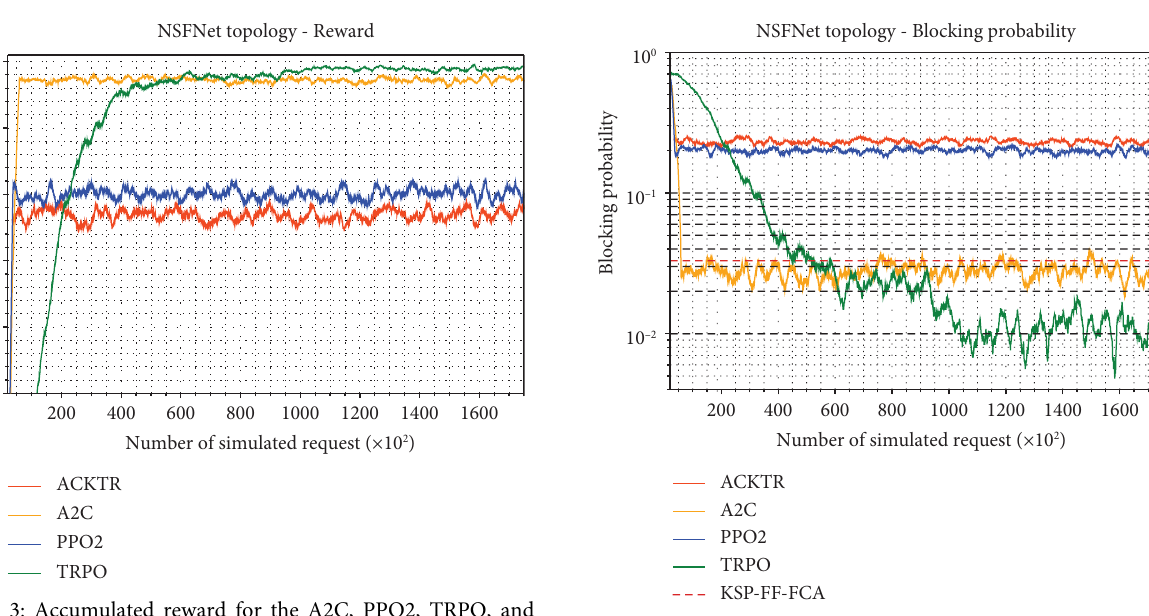
Figure 5: Blocking probability for A2C, PPO2, TRPO, and ACKTR in NSFNet Topology.